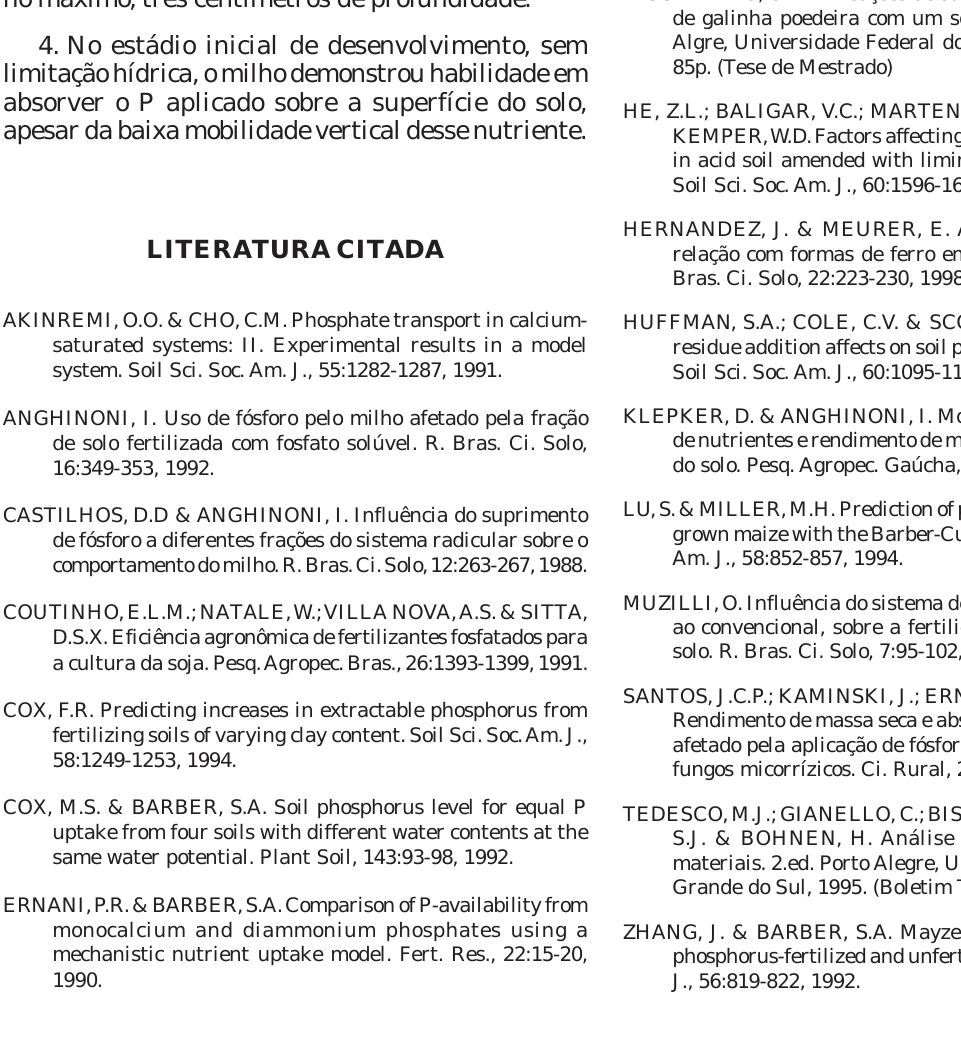
FIGUEIREDO, O.A.R. Reações de superfosfato triplo e de cama de galinha poedeira com um solo Latossolo Bruno. Porto Algre, Universidade Federal do Rio Grande do Sul, 1985. 85p. (Tese de